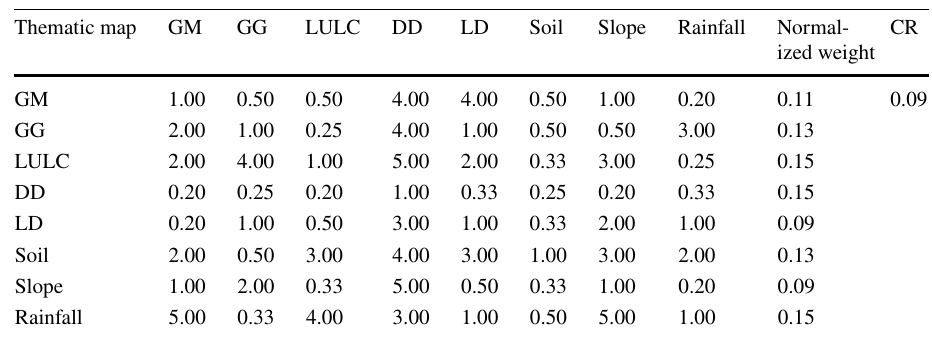
Table 4 Pair-wise comparison